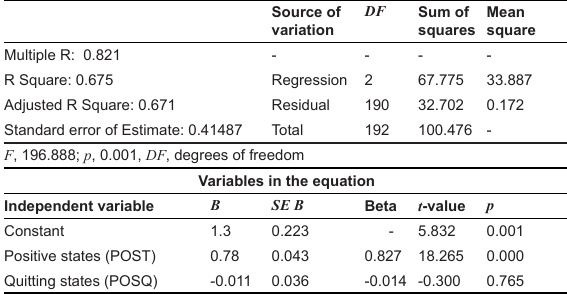
Multiple regression of positive states on entrepreneurship orientation factor ii (dv)